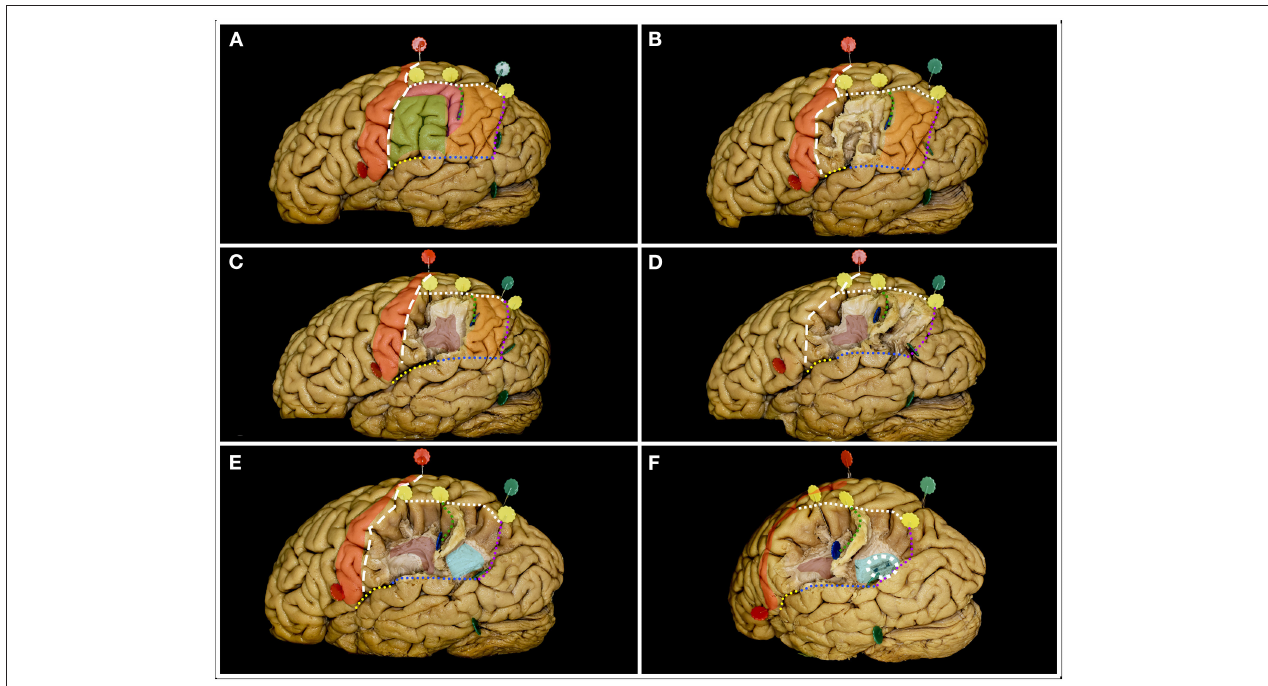
FIGURE 4 | The figure represents the surgical perspective of the surgical field within the inferior parietal lobule from a lateral perspective. (A) The IPL is located posterior to the postcentral sulcus (white rectangle line) and to the postcentral gyrus (red), inferior to the intraparietal sulcus (white square line), anterior to the parietotemporal line (purple dots) and superior to the occipitotemporal line (blue dots) posteriorly and the end anteriorly by the posterior ramus of the lateral fissure (yellow dots). Within the IPL, the SMG (green) and AG (orange) are identified. In the typical pattern no additional gyri behind the postcentral sulcus within the IPL can be identified. When additional gyrus is located between the postcentral sulcus and the SMG or between SMG and AG the pattern is defined as PreSMG or PreAG, retrospectively ( 9). In this case, the additional gyrus (pink) was identified between the AG and SMG, bordering the anterior edge of the AG. The two gyri are separated by the inferior ramus of the IPS, the sulcus of Jensen (green square line). (B) Here, the most superficial layer of the fibers within the SMG was constituted by short u-fibers. (C) Removal of the u-fiber system reveals the AF/SLF system (burgundy), its genu and posterior segment of the horizontal as well as superior segment of the vertical ramus. The sulcus of Jensen marks the point posterior to the most posterior point of the genu of the AF/SLF complex. (D) Posteriorly within the AG, the u-fibers go deeper than anteriorly. (E) After removal of these fibers, fibers deeper than the AF/SLF complex within the SMG, the fibers of the sagittal stratum (light blue) running in the anteroposterior direction were identified. (F) When the SS fibers were separated, the occipital horn and posterior part of the atrium of the lateral ventricle (white square circle) were